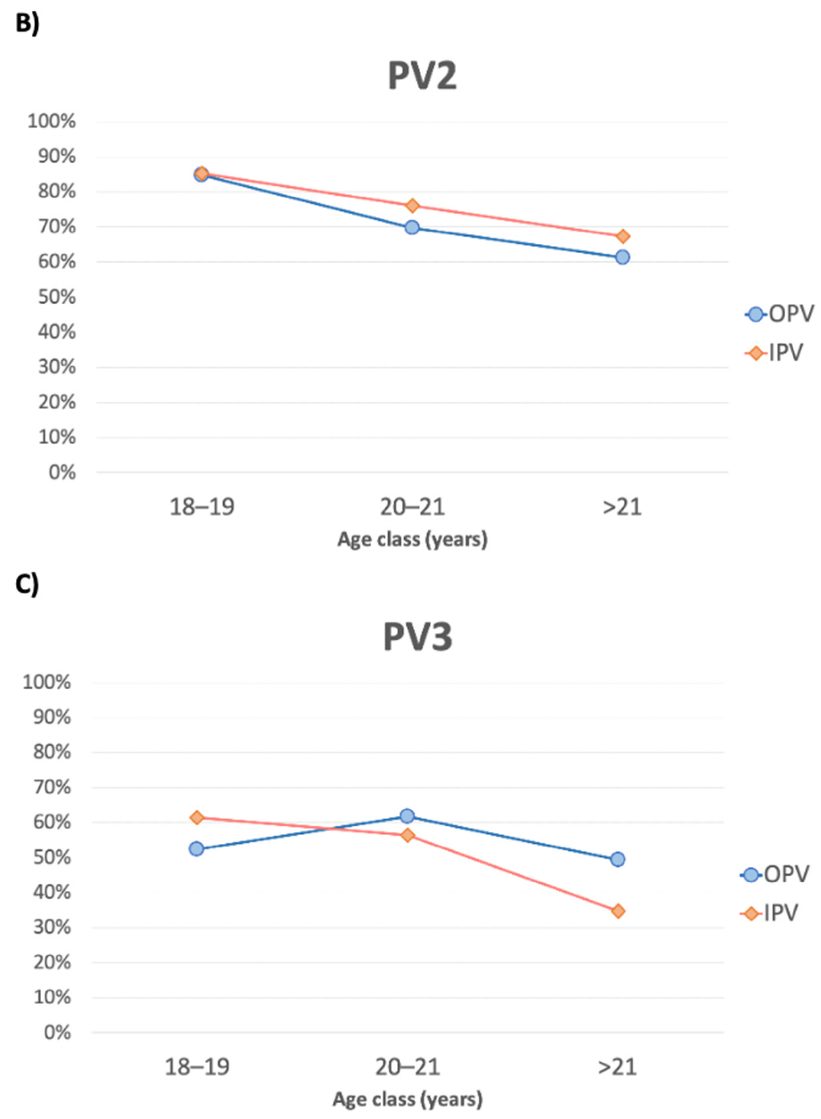
Figure 2. Prevalence (%) among the study participants of high protective titer of neutralizing antibodies against PV1 ( A ), PV2 ( B ), and PV3 ( C ), per age class. In the multivariate logistic regression, there was no association between the sero- prevalence of anti-PV1 antibodies and any of the analyzed determinants ( p > 0.05; not